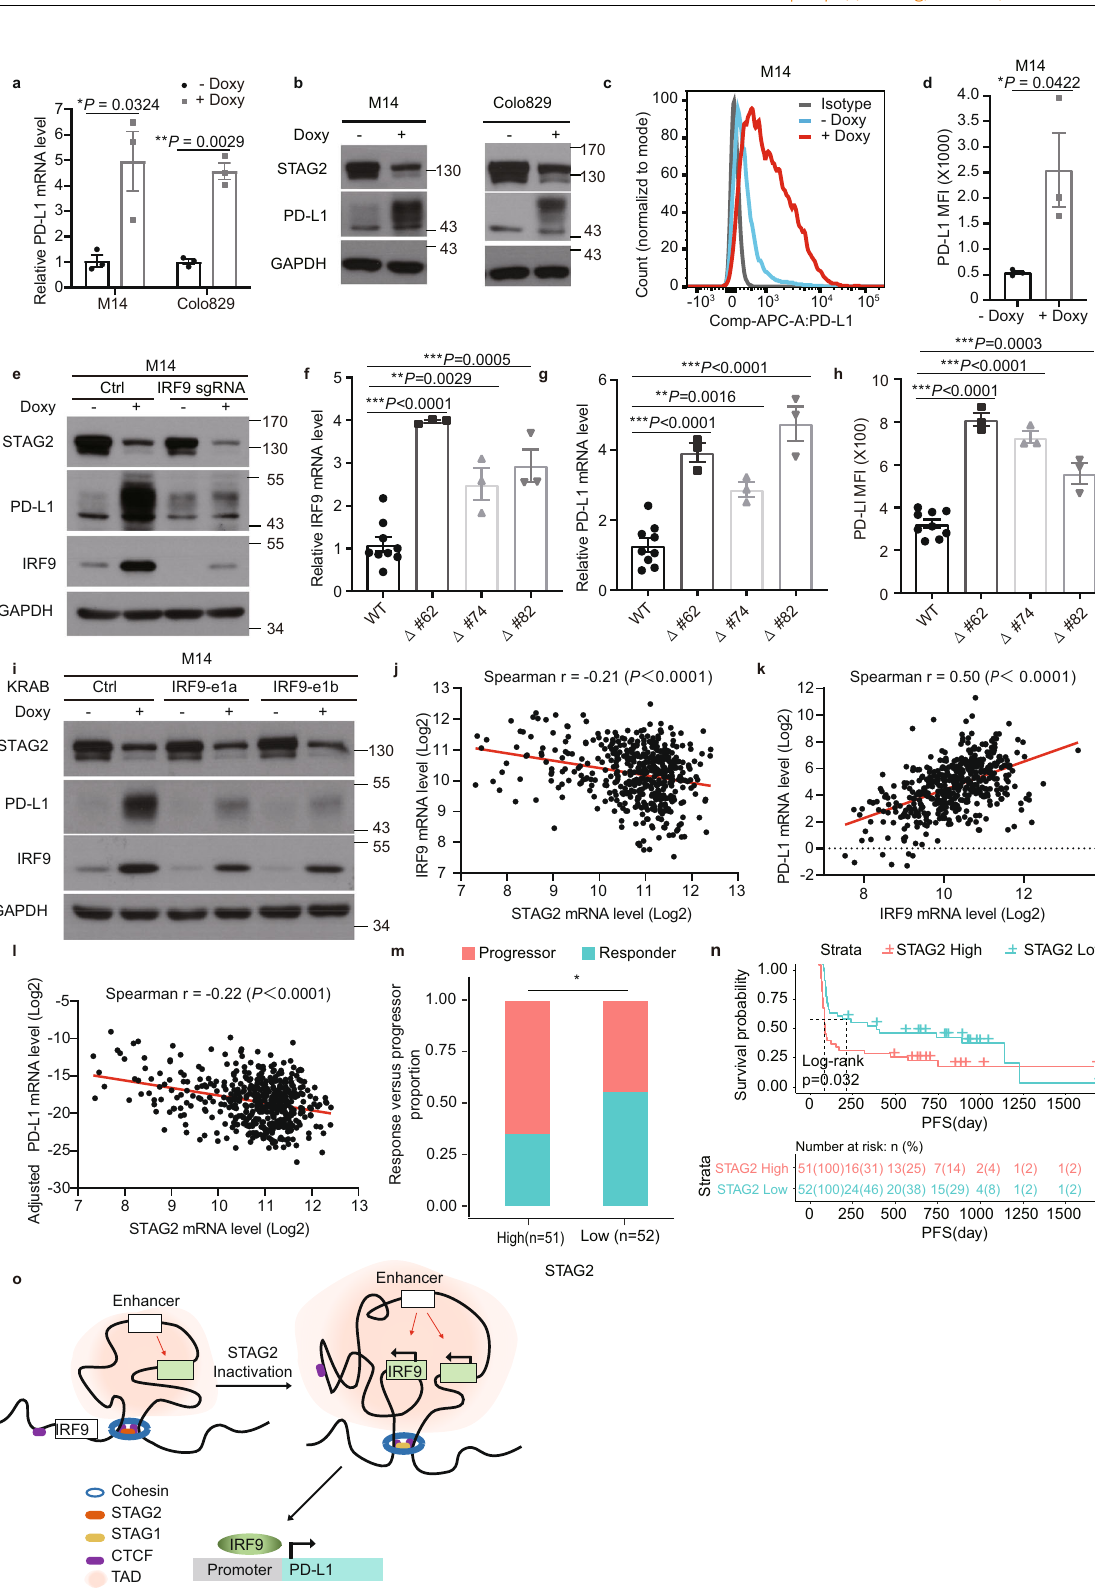
respectively, and then normalized by the average contacts in the fi rst off-diagonal of Hi-C maps. We did this process for both intra- and inter-chromosomal contacts over all chromosomes. TADs were identi fi ed by using fi ndTADsAndLoops.pl and TADbit 48 in 100 kb bin size We then calculated the TAD length as the difference between the two boundaries for each TAD and plotted the distribution for STAG2 WT and KD cells. A t -test on the mean value of the WT/KD distribution was performed